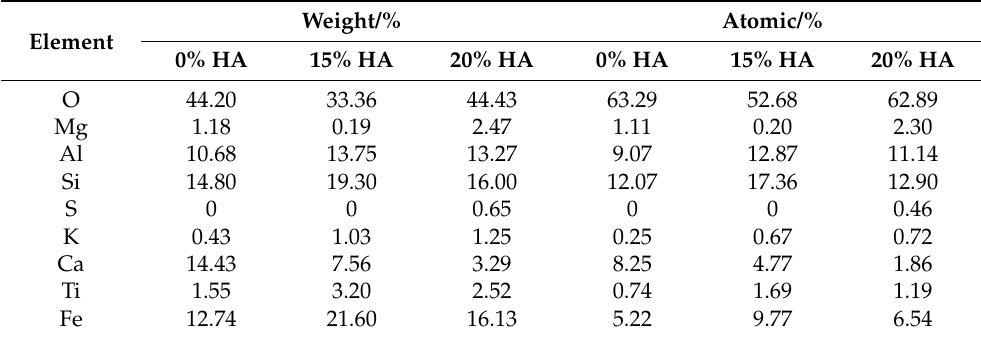
Figure 12. EDS diagram of cemented soil samples. ( a ) 0% HA content. ( b ) 15% HA content. ( c ) 20% HA content. Table 3. The proportion of elements in